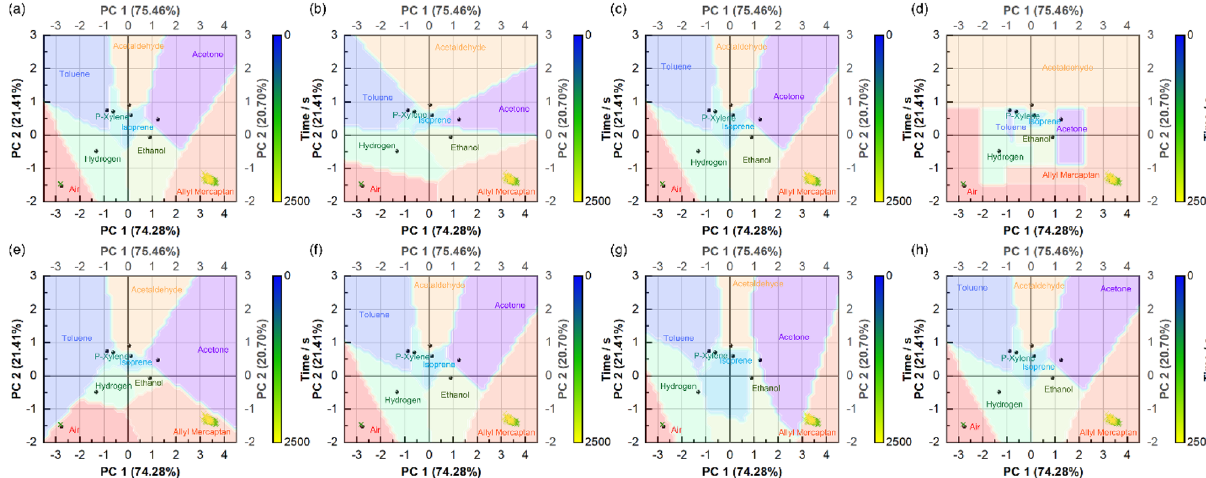
Figure 6. Gas classification models by ( a ) Gaussian naïve Bayes, ( b ) linear discriminant analysis, ( c ) k-nearest neighbor, ( d ) Random forest, ( e ) Linear support vector classification (SVC), ( f ) SVC with linear kernel, ( g ) SVC with polynomial kernel, and ( h ) SVC with radial basis function